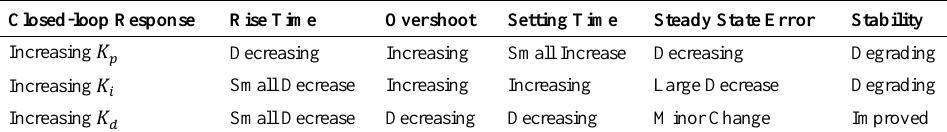
Table 1. Response of each combination of constant values p, i, and